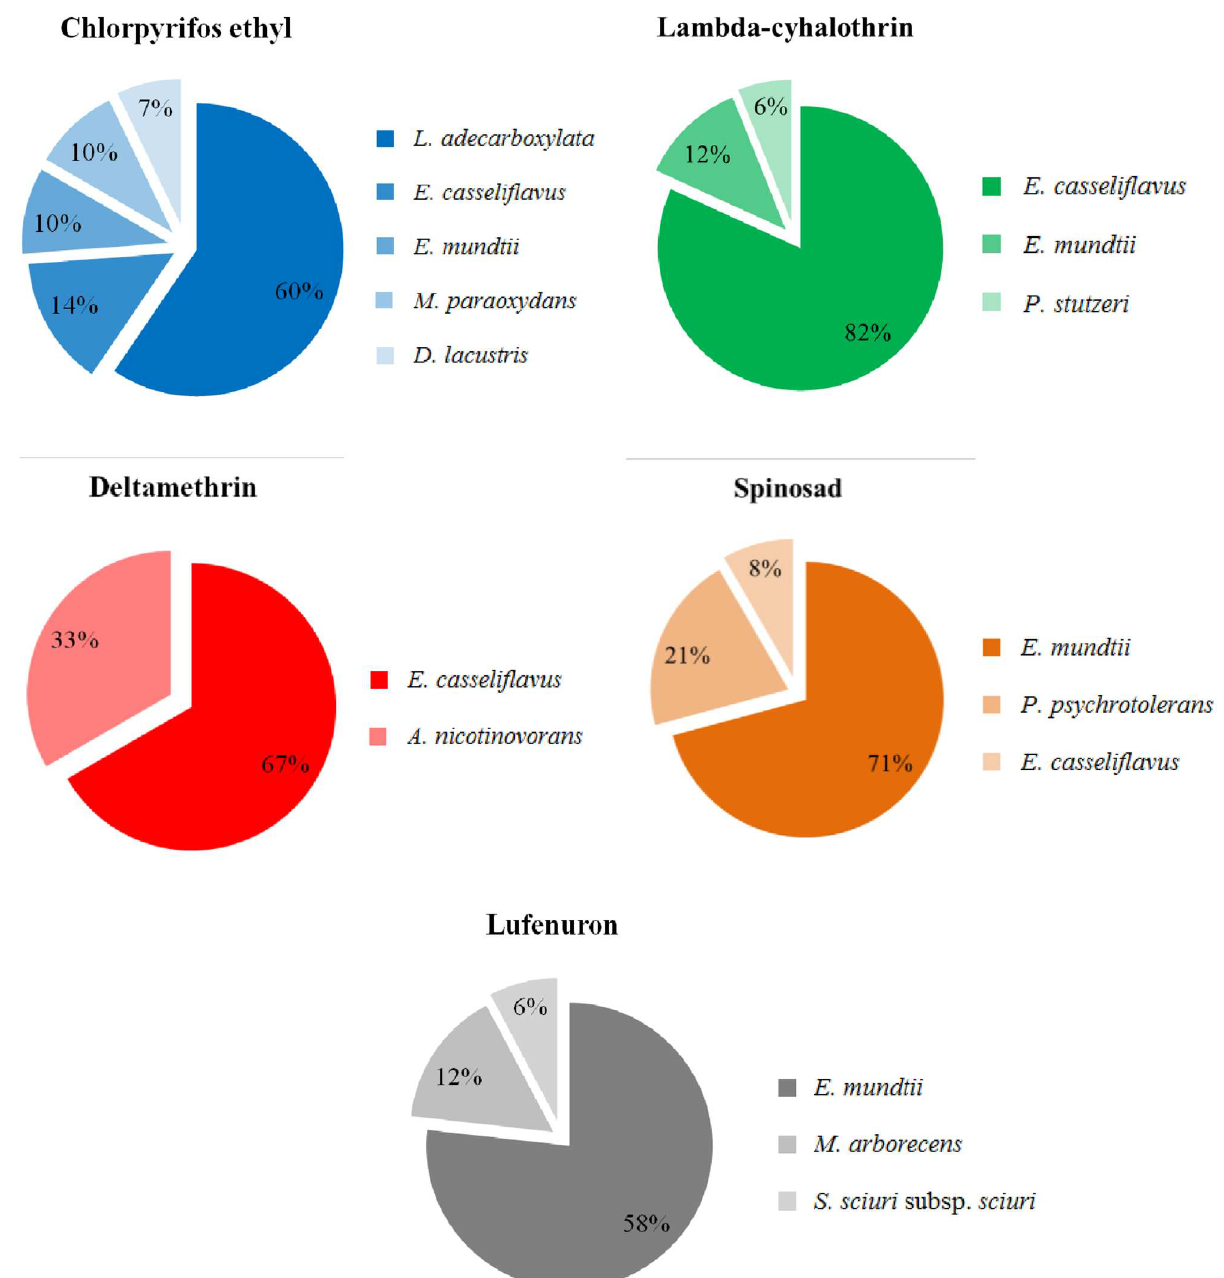
Fig 1. Relative proportion (%) of phylotypes isolated from the larval gut of insecticide-resistant lines of Spodoptera frugiperda afterr RFLP-PCR analysis and partial sequence (550 pb) of the 16S rDNA. Putative identificationobtained after heuristicsearch of 1350 bp of 16S rDNA against sequencesavailablein the NCBi and EzTaxon-e databases.